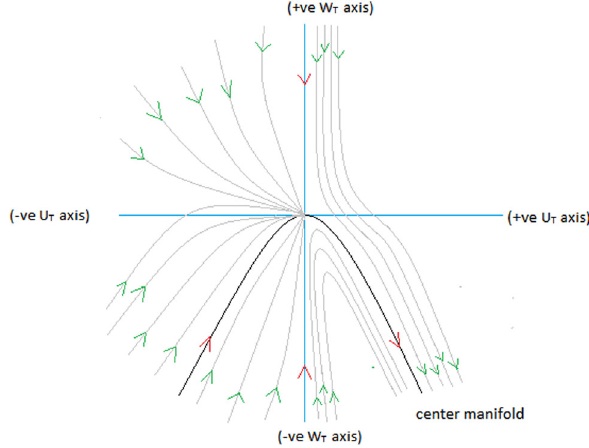
Fig. 9 Projection of vector field on the ( U T W T )-plane near the origin for the critical point P 5 ( α =3)